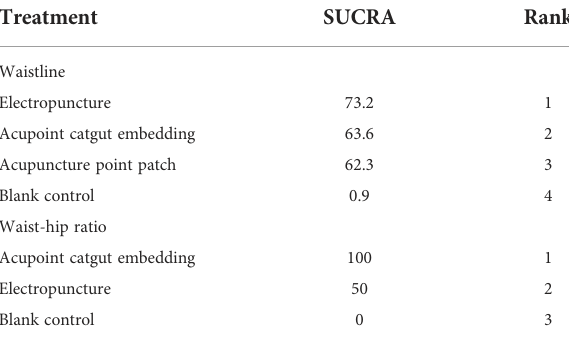
TABLE 7 Ef fi cacy ranking of mesh meta-analysis: waistline and waist – hip ratio. Treatment